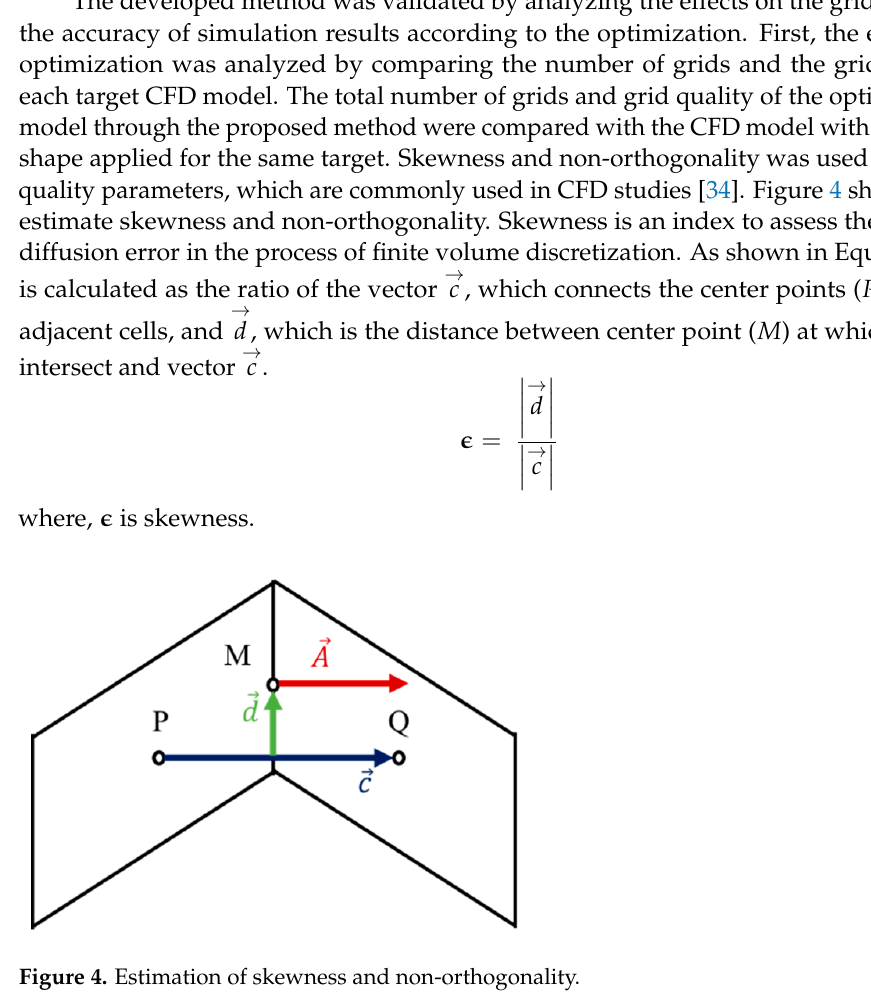
→ c ), which connects the → A ), at the center point M of the intersection